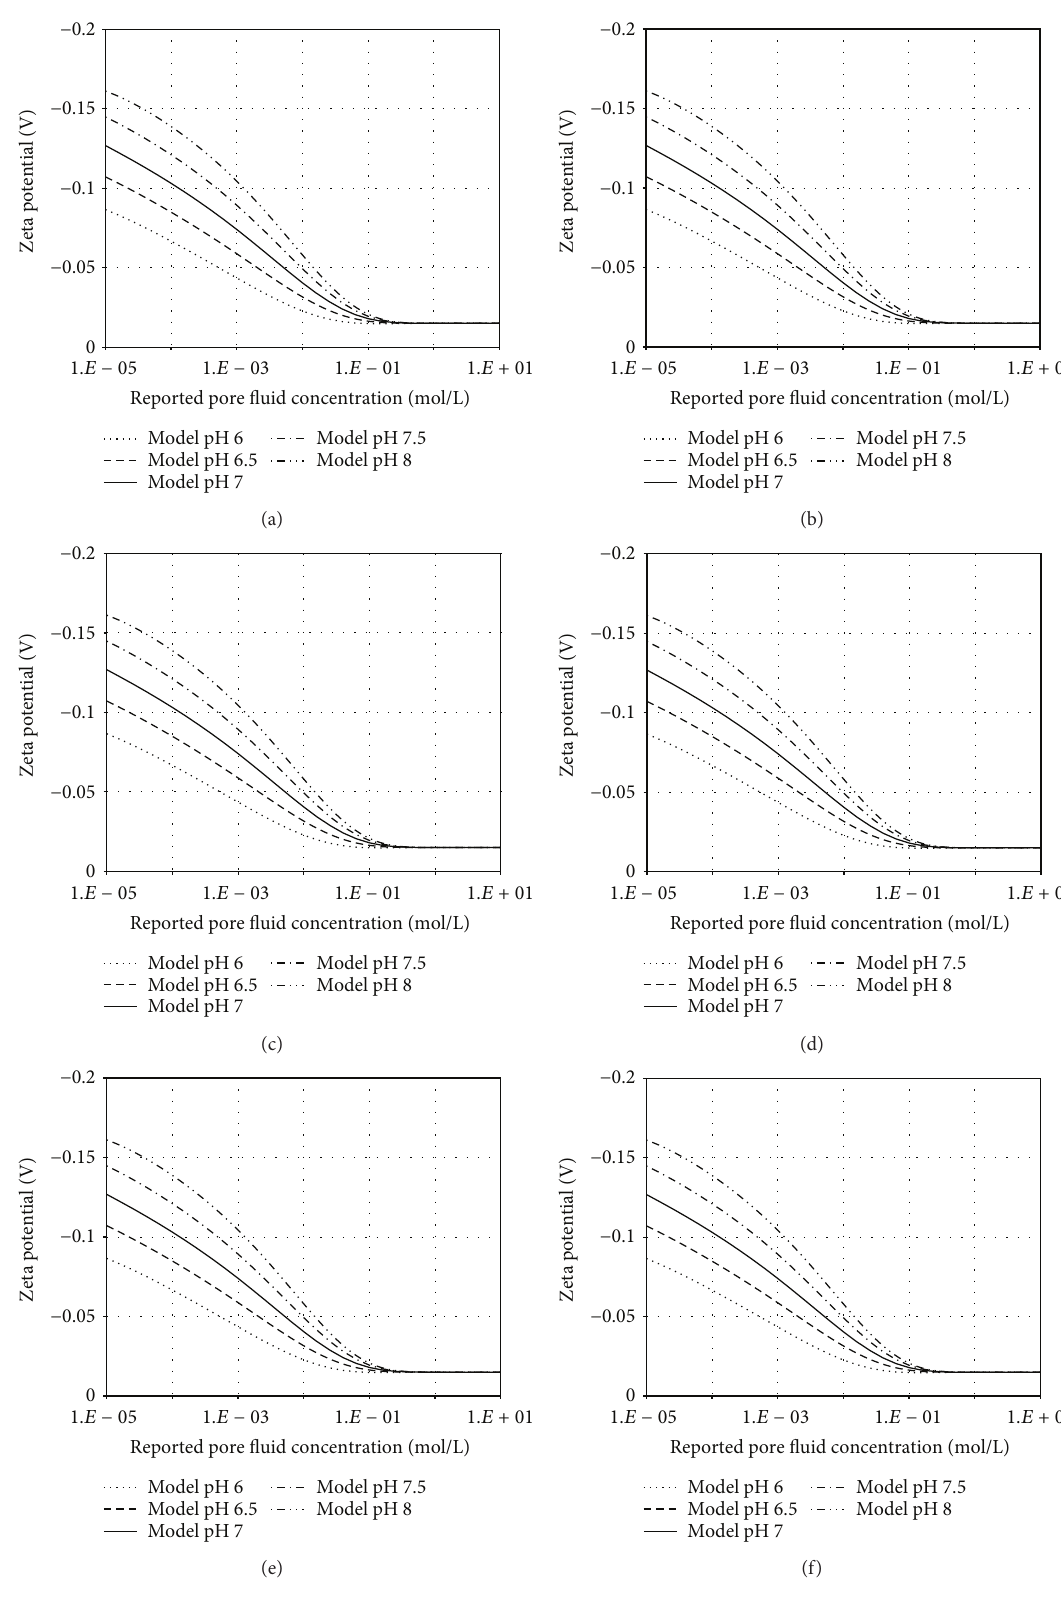
Figure 3: Zeta potential calculated during the streaming potential coefficient modelling for six samples from Luong and Sprik’s [1] data as a function of pore fluid salinity and pH together with the corresponding experimental measurements. (a) BereaUS3, (b) DP46i, (c) DP50, (d) BEN7, (e) EST, and (f)